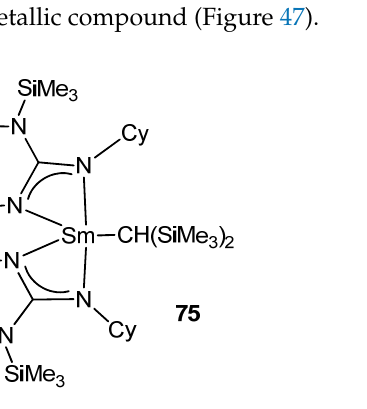
Figure 47. First reported organolanthanide complex with guanidinato ligands.